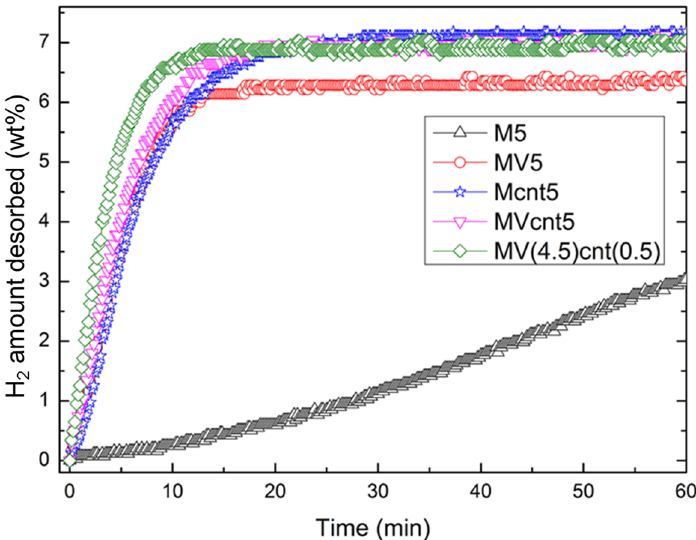
Figure 9. Hydrogen desorption of M5, MV5, Mcnt5, MVcnt5 and MV(4.5)cnt(0.5) at 300 °C with an initial pressure of 1 KPa, respectively.